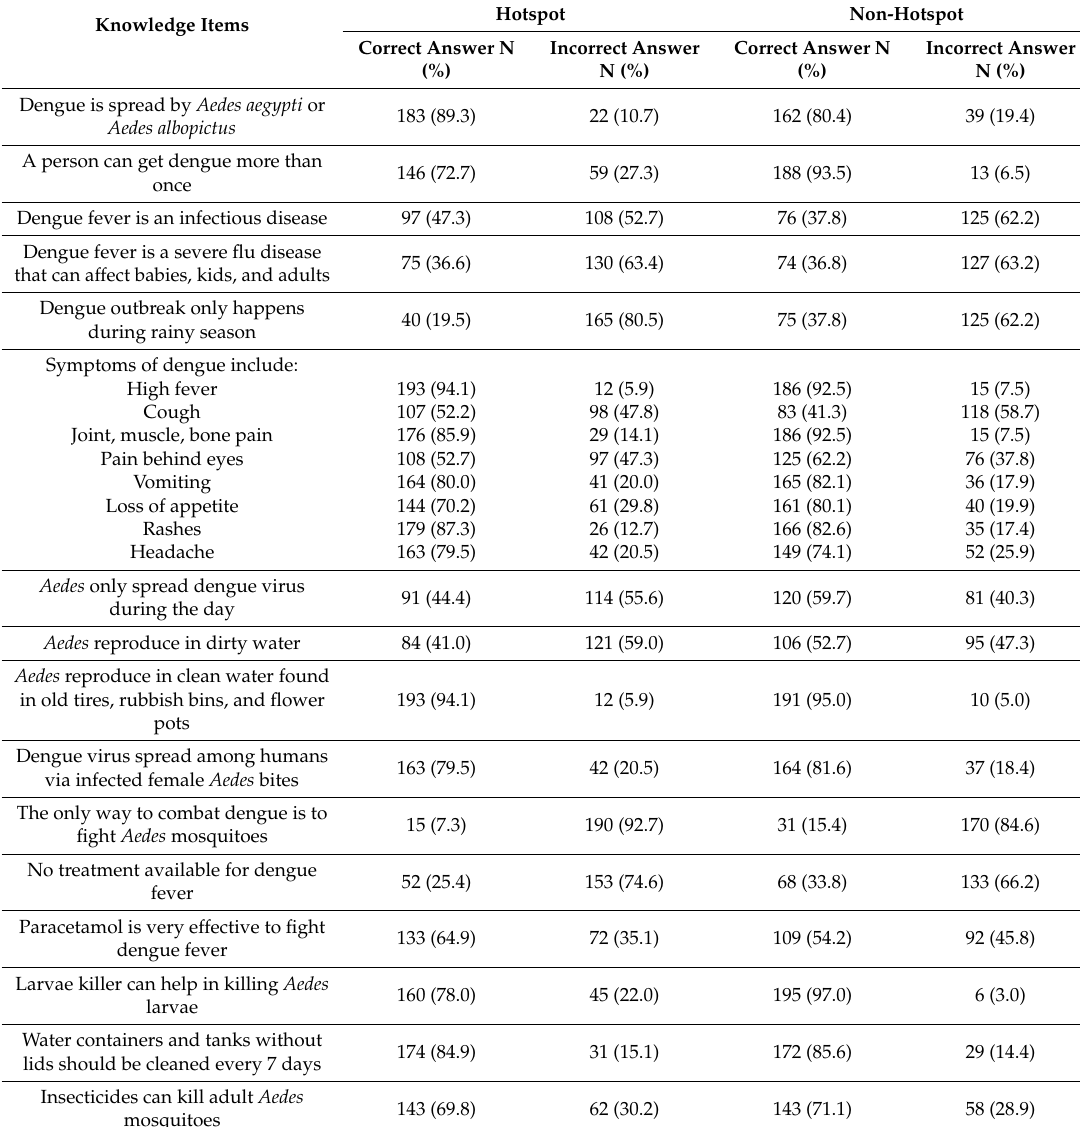
Table 2. Knowledge of Respondents’ Towards Dengue